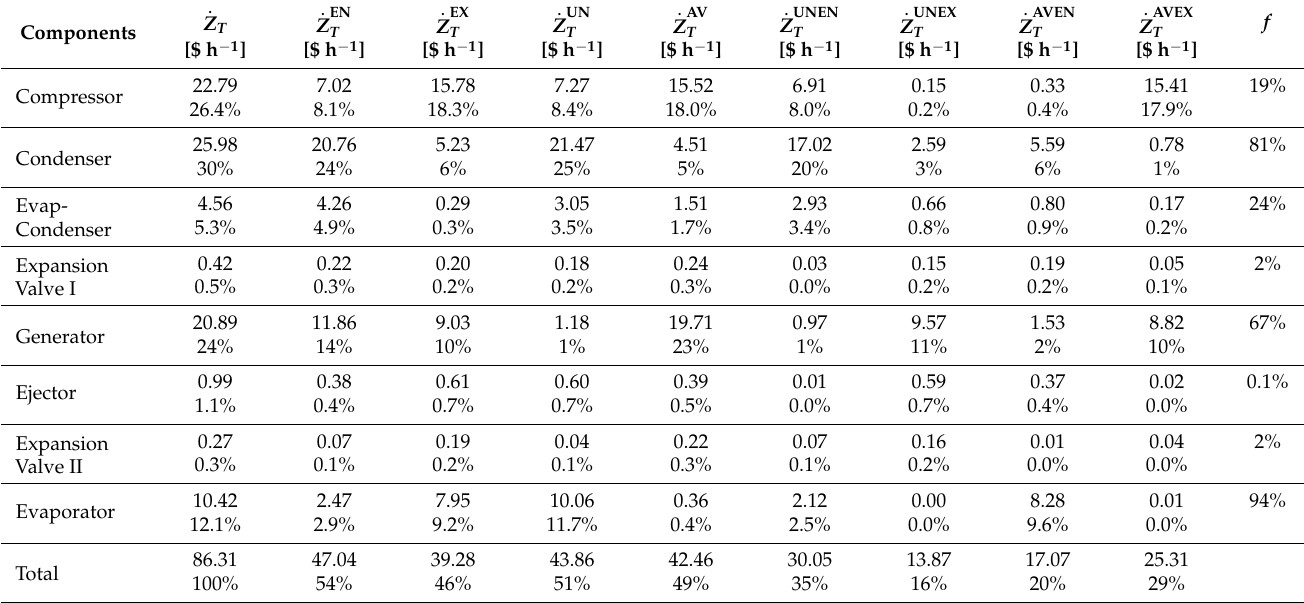
Table 9. Investment cost rate of the system components.